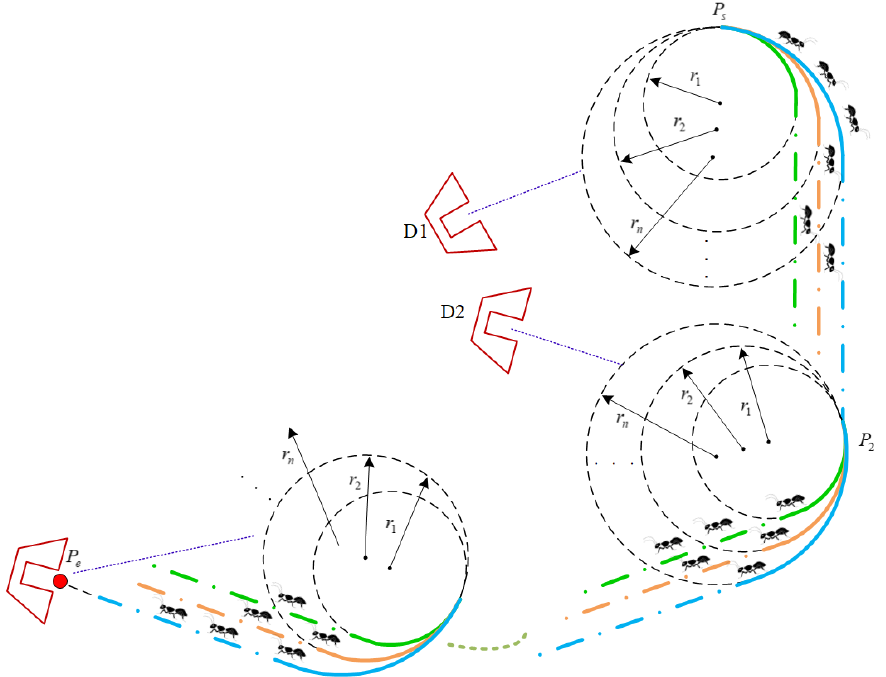
Figure 9. Automatic docking trajectory algorithm-based ant colony optimization